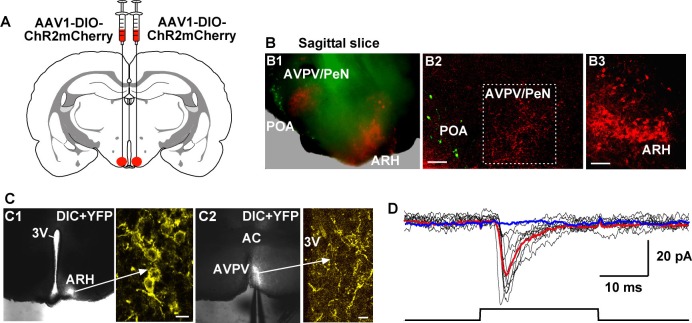
Photoactivation of Kiss1ARH fibers excites Kiss1AVPV/PeN neurons via glutamate release.(A) Schematic drawing of a coronal section showing the bilateral viral injections in the ARH with AAV-DIO-ChR2:mCherry. (B) Sagittal brain slice (B1) and confocal images from the slice (B2, 3) of mouse bilaterally injected with a ChR2-mCherry-expressing viral vector into the ARH of Kiss1-Cre::GnRH-EGFP female mouse. Projections from Kiss1ARH neurons (B3) to the AVPV/PeN are illustrated (B2). Green neurons in the POA illustrate the location of GnRH neurons in the sagittal brain slice. Scale bars, 100 µm (B2, B3). (C) Overlay of epifluorescence (YFP) and differential interference contrast (DIC) images of a coronal arcuate slice showing injection site (C1) in a Kiss1-Cre:ChR2:YFP mouse (arrow points to high power image of labeled neurons in the ARH) and fiber-projections to the AVPV (C2; arrow points to labeled fibers in the AVPV area that are being photostimulated). Scale bars = 10 µm. (D) Example of light-evoked fast EPSCs in a Kiss1AVPV/PeN neuron (mean response: 33.2 ± 9.7 pA, n = 5). Red trace indicates averaged sweeps. Blue trace illustrates that the AMPA- and NMDA-mediated currents (EPSCs) were blocked with CNQX (10 μM) and D-AP5 (50 μM). Following recording, cells were harvested for scRT-PCR determination of Kiss1 mRNA expression. All recorded AVPV/PeN cells (n = 5) expressed Kiss1 mRNA (data not shown). ARH, hypothalamic arcuate nucleus; AVPV/PeN, anteroventral periventricular and periventricular preoptic nuclei; POA, preoptic area.